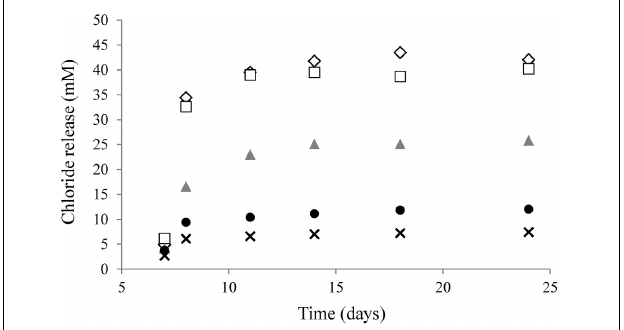
FIGURE 2 | Corrinoid starvation effect on PCE dechlorination by D. restrictus by lowering the initial concentration of corrinoid supplemented into the medium. Corrinoid concentration: 250 μ g/L (white diamonds), 50 μ g/L (white squares), 10 μ g/L (gray triangles), 5 μ g/L (black circles) and 1 μ g/L (black